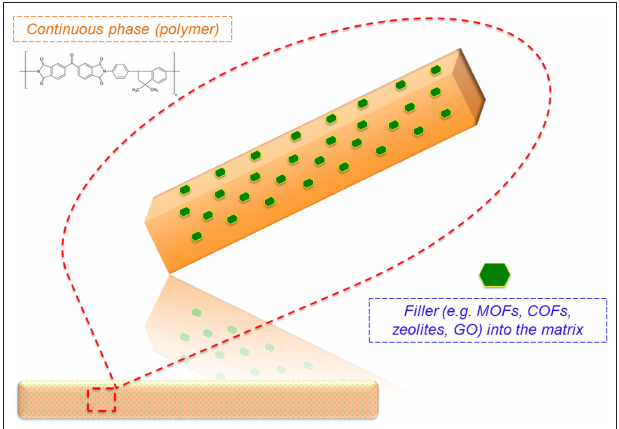
FIGURE 2 | Graphical drawing of a mixed matrix